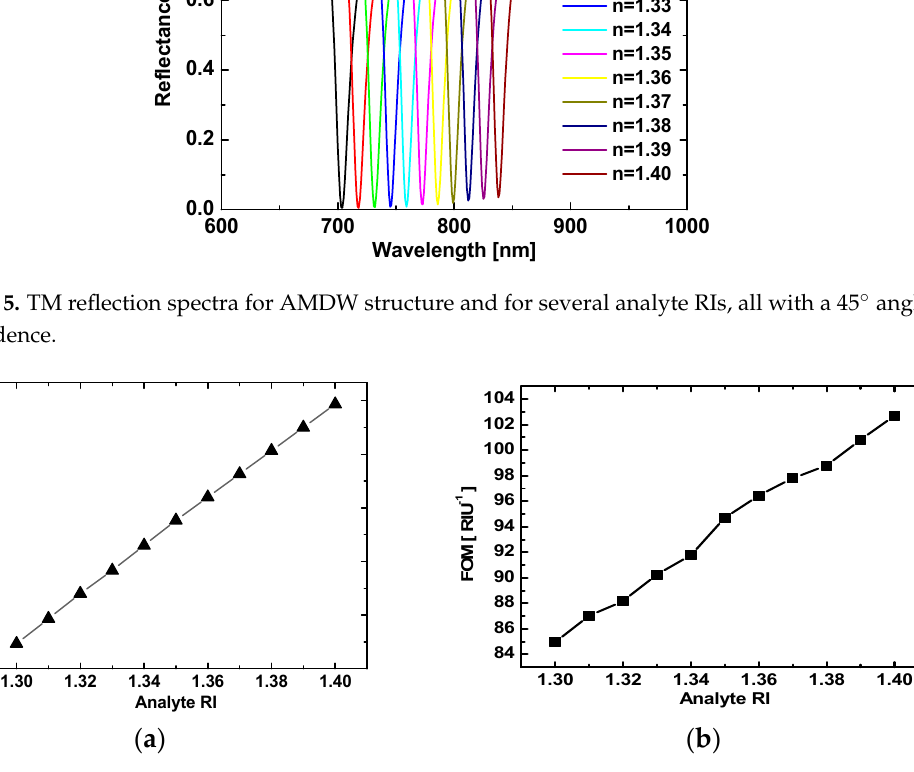
of the analyte RI with a linear fit producing a slope of 1339 nm/RIU, and the ( b ) FOM as a function of